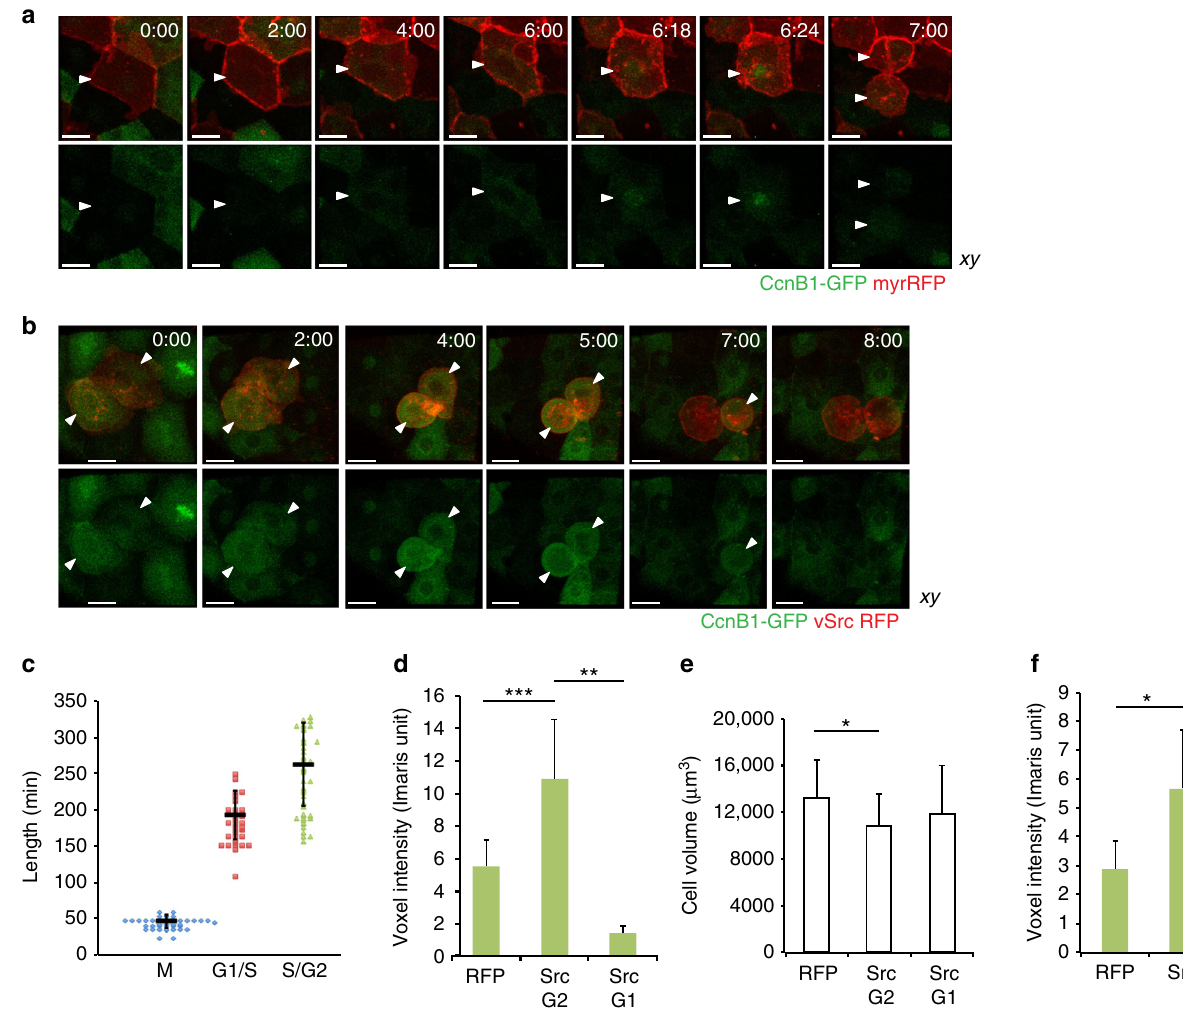
Fig. 4 vSrc modulates cell cycle progression. a , b Time-lapse imaging of Cyclin B1-GFP in cell extrusion. Transgenic embryos obtained from a line expressing a cell cycle progression marker speci fi cally in the EVL (Krt18:CcnB1-GFP) crossed with the Krt18:KalTA4-ERT2 line were injected with the construct UAS:myr-Cherry ( a ) or UAS:myr-Cherry-vSrc ( b ). Movies were taken over 8 h. Frames were extracted from a representative movie at indicated times from the tailbud stage. White arrowheads indicate cells that undergo mitosis or become extruded. Scale bars, 10 µ m. c Length of different cell cycle phases of the EVL cells from the CcnB1-GFP line. The cell cycle phases are de fi ned as follows; M is the time from the nuclear import of CcnB1-GFP until completed cytokinesis; G1/S is the time from completed cytokinesis until the GFP signal returns to the cytoplasm; S/G2/M is the time of the GFP signal present in the cytoplasm until mitosis. Each mark represents a single cell. Black lines represent mean values ± standard deviation (s.d.). Data collected from fi ve movies in three independent experiments. d Mean voxel intensity± s.d. of the CcnB1-GFP signal in single cells immediately before extrusion (myr- Cherry-vSrc) or division (myr-Cherry). Data collected from 31 extruded vSrc cells and 31 dividing myr-Cherry cells in 12 movies per condition from fi ve independent experiments. *** P = 2.1 × 10 − 7 (Student ’ s t -test), ** P = 8.4 × 10 − 4 (Student ’ s t -test). e Cell volume analysis before division and extrusion. Average volume ± s.d. of the cells used for CcnB1-GFP signal quanti fi cation immediately before extrusion or division (Fig. 4d). * P < 0.05 (Student ’ s t -test). f Mean voxel intensity ± s.d. of the green channel (CcnB1-GFP) in myr-Cherry cells and myr-Cherry-vSrc cells at time 0 of a time-lapse from cells remaining in the epithelium. Data collected from 11 embryos per condition in fi ve independent experiments. * P = 0.005 (Student ’ s t